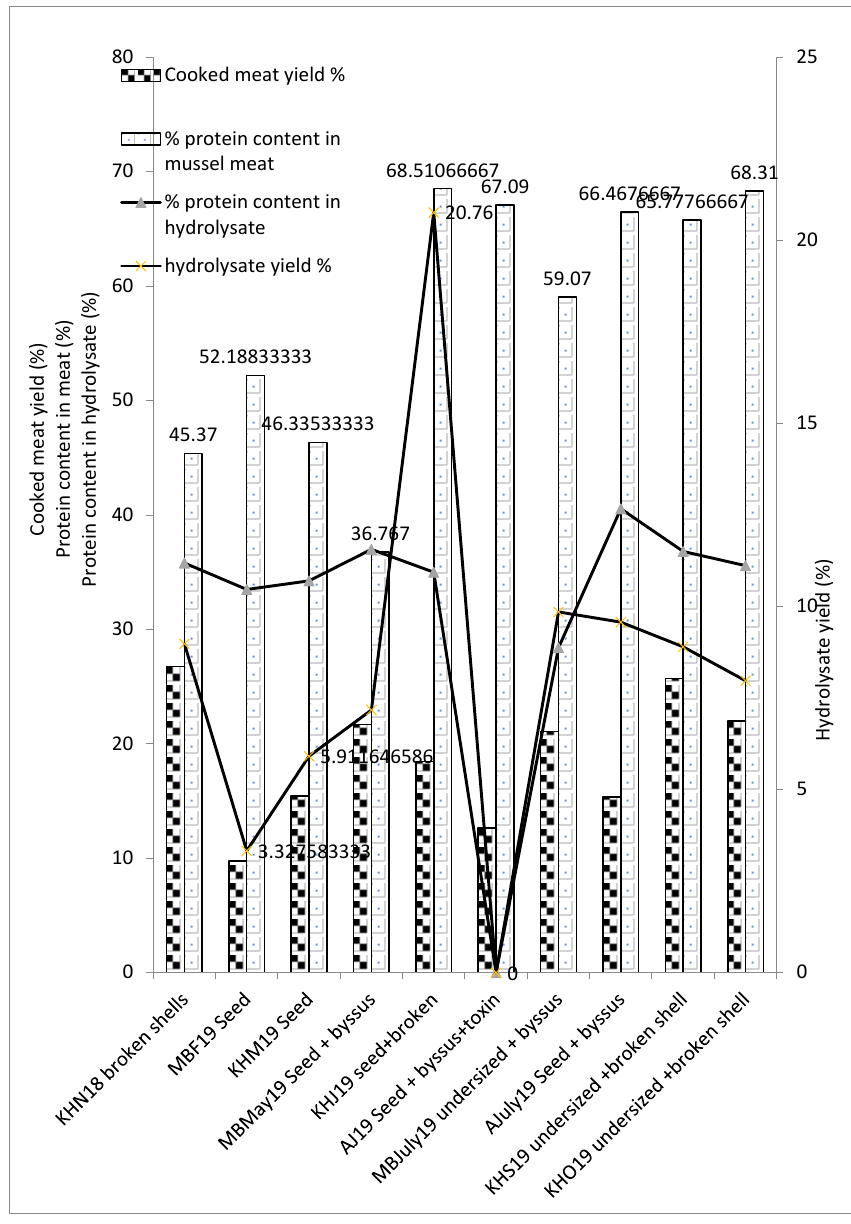
Figure 3. Changes in meat yield (% w / w ), hydrolysate yield (% w / w ) and protein content (% w / w ) for mussel by-products and Protamex ® hydrolysates. The 10 samples from the three sampling sites Mulroy bay (MB), Killary harbor (KH) and Ardgroom (A), collected from November 2018 to October 2019, were used for analysis. Yields were determined gravimetrically, whereas protein content was estimated using the Dumas method (AOAC 968.06 method using Leco FP628). Analysis was performed in triplicate (n = 3). Bars sharing the same letter are not significantly di ff erent according to Tukey’s HSD